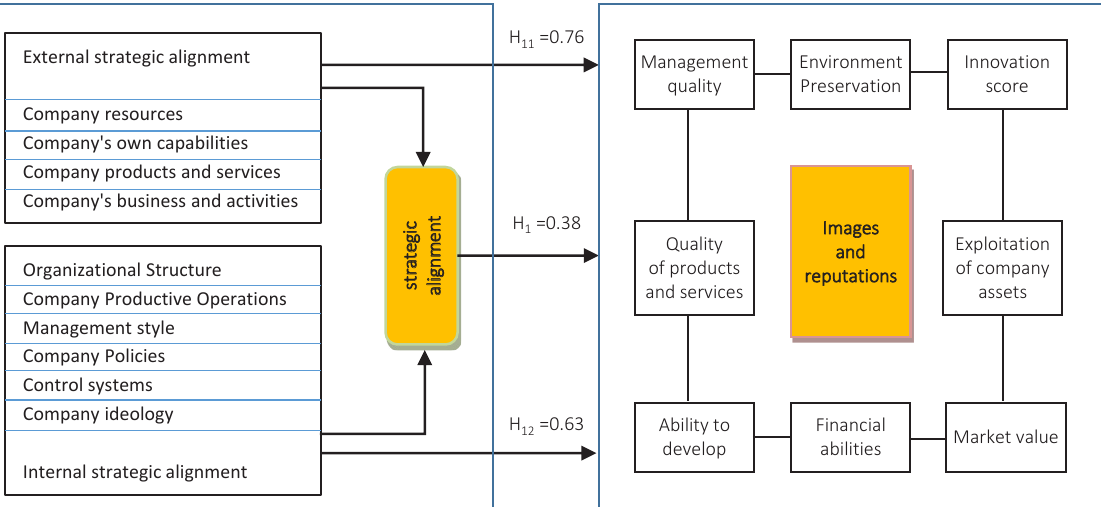
Figure 1. Strategic alignment and its impact on the creation of an organization’s reputation and image